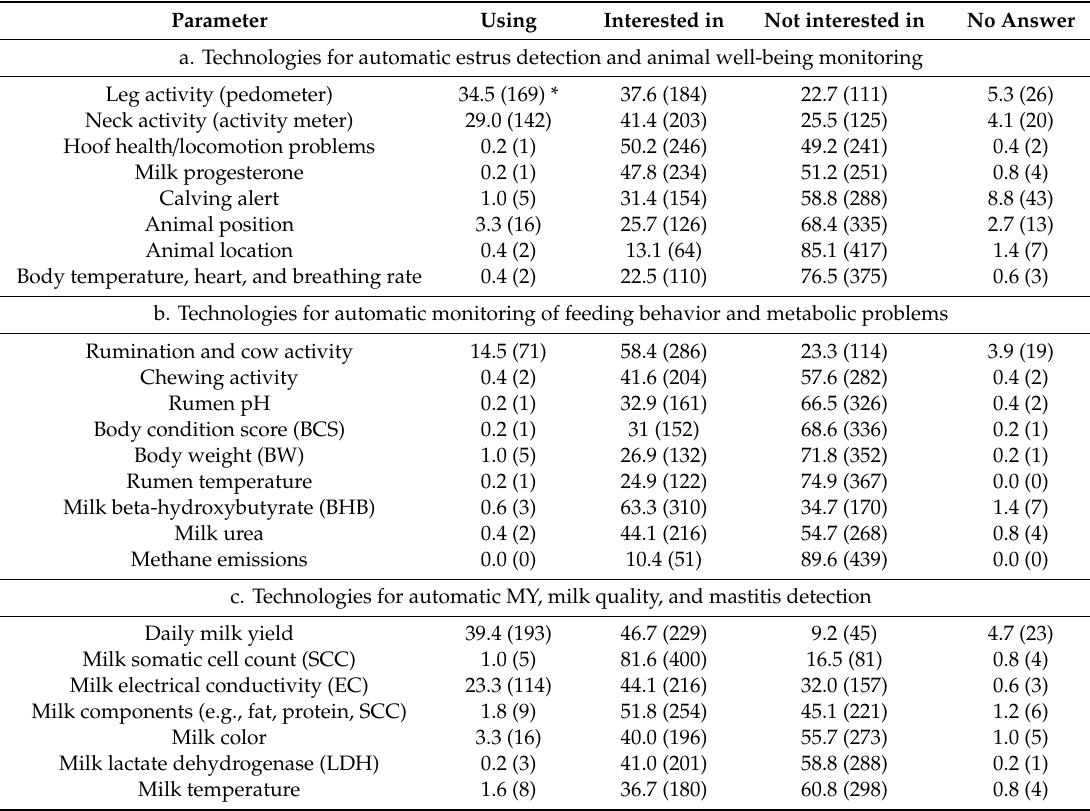
Table 2. Percentages of respondents using, interested, or not interested in using precision livestock farming (PLF) sensors to measure the listed parameters for the automated monitoring of estrus and animal well-being (a), feeding behavior and metabolic problems (b), and individual MY, milk quality, and mastitis detection (c) in the sample